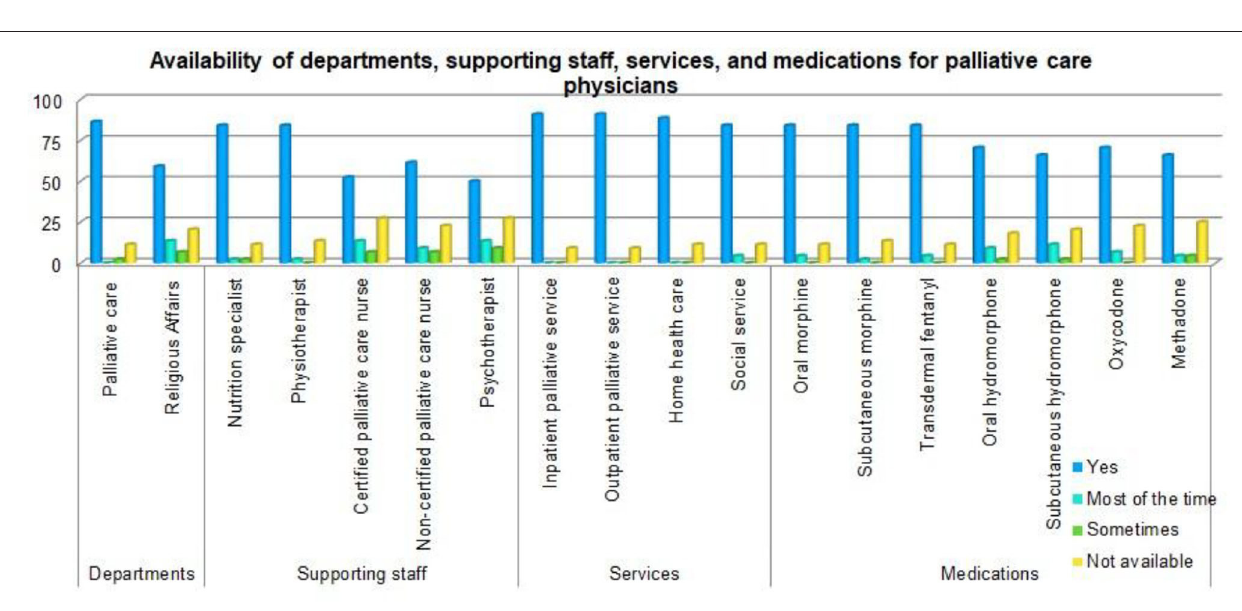
FIGURE 2 | Availability of support services for palliative care physicians in Saudi